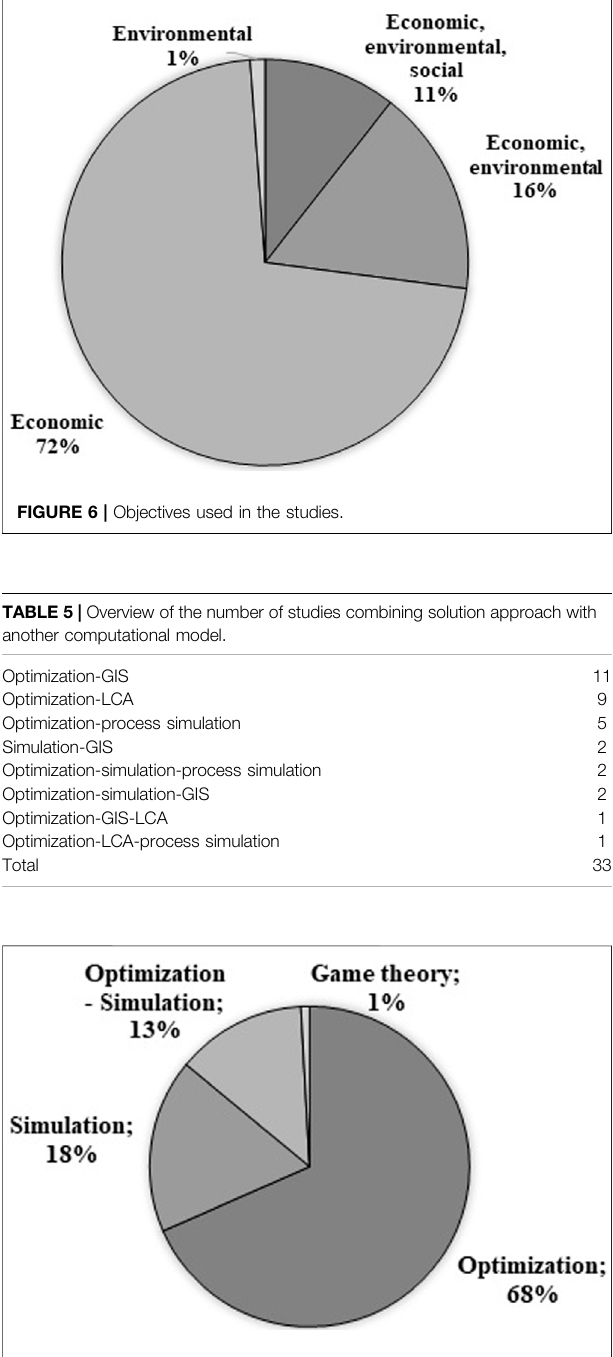
FIGURE 7 | Solution approaches used in the